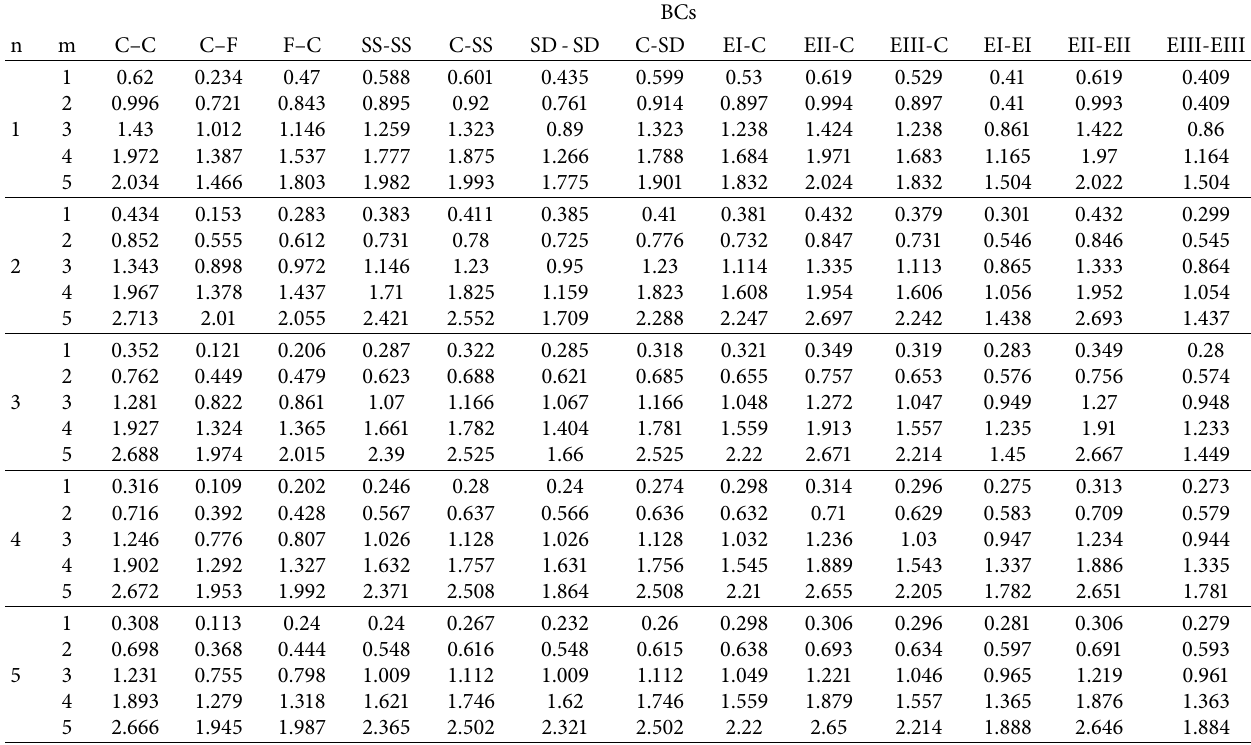
Table 8: The frequency parameters for laminated composite conical shell with variable thickness and different boundary conditions.